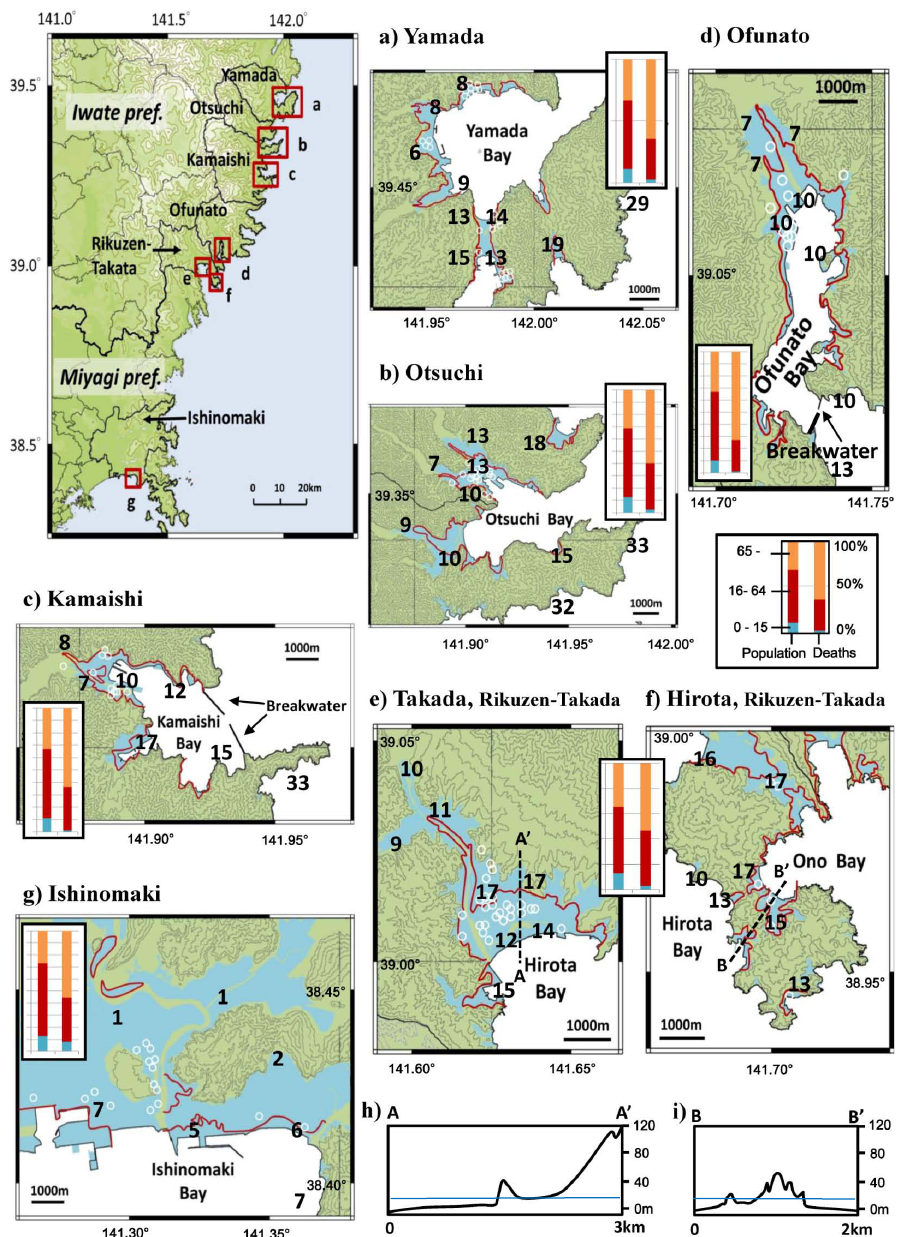
Fig. 2. The six cities in which interviews were conducted. (a)–(g) the map of he interviewed area of each city shown with topographic contour lines at 50m intervals. The inundation areas of the 2011 Great East Japan Earthquake (light blue) are provided by the Association of Japanese Geographers ( { 6 } , No. 6 in Table 1). The red lines show the tsunami inundation limits that were forecasted in 2006 by the Iwate and Miyagi prefecture offices, based on the scenario earthquakes A, B, and C in Fig. 7 (Iwate and Miyagi prefecture offices { 12 } , No. 12 in Table 1). The forecast inundation limits at each site were taken as the highest values among the three models. Numerals are inundation or runup heights of the observed 2011 tsunami in meter (Tohoku Earthquake Tsunami Joint Survey Group { 5 } , No. 5 in Table 1). The major difference is in height; the 2011 tsunami wave heights were 2–5 times higher than the forecasted heights. Each map shows the percentages of the population (left bar) and the deaths (right bar) for three age groups (0–15, 16–64, and 65 and above from bottom to top), where the data were collected from Tani (2012). Subdivision maps Takada and Hirota of Rikuzen-Takada city are depicted separately to compare evacuation behaviours between the two divisions, where the tsunami has wave heights of 12–15m. Takada is the main subdivision of the city of Rikuzen-Takada, a commercial and business town lying in a wide lowland sand dune. Hirota is also in Rikuzen-Takada and is located in narrow lowlands, where slopes have developed between hills and the seawater is visible almost everywhere. Topographic profiles along Takada (h) and Hirota (i) are shown with a line of 15m. The number of interviewees who felt the 2011 Great East Japan Earthquake at each location is depicted in Fig. A in Supplement on the same map as Fig.